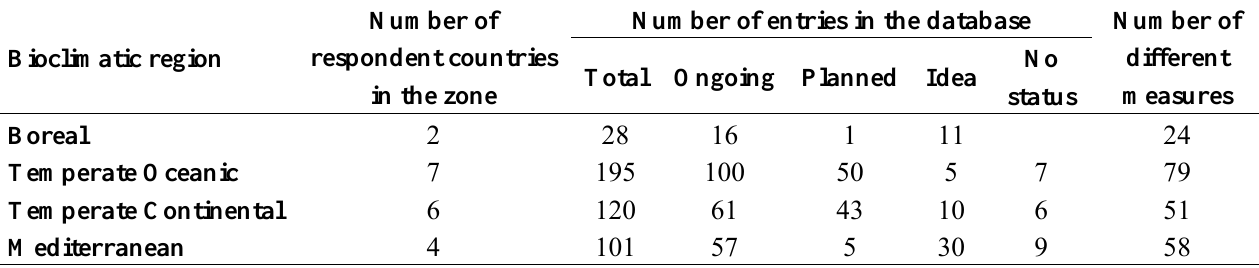
Table 1. Number of database entries (measures listed by country respondents) by bioclimatic regions and status of the measures. Since similar measures are listed by several countries, the last column shows the number of different measures per bioclimatic